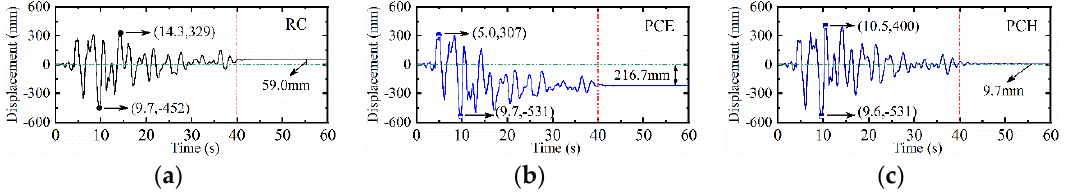
Figure 14. Time history of the top displacement under Wave 2 (PGA: 600 gal): ( a ) RC frame; ( b ) PCE frame; ( c ) PCH frame.